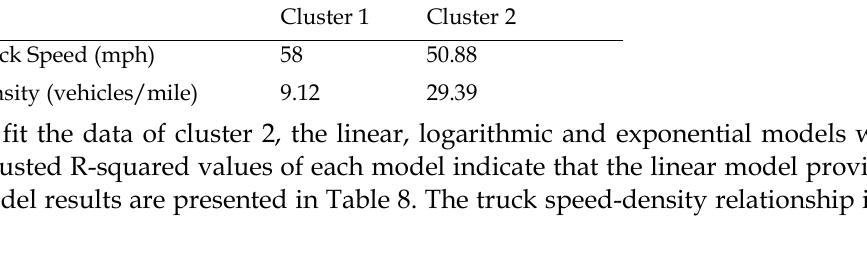
Table 8. Case study II the second cluster fitted results of two clusters analysis